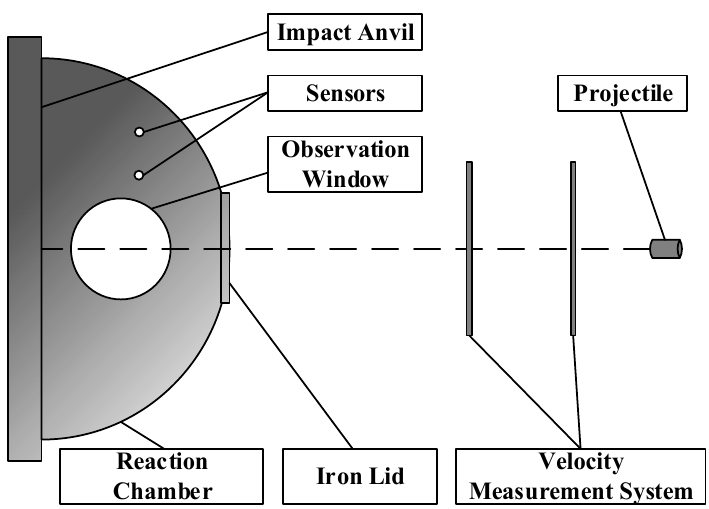
Figure 1. Schematic illustration of the quasi-sealed chamber device. The Zr/PTFE and Ti/PTFE RMs were packed into steel shells to ensure that the materials would not be broken when launching or hitting the iron lid. The size of Zr/PTFE and Ti/PTFE RMs was Φ 10 mm × 9 mm, the mass of cylindrical steel shells was 4.6 ± 0.1 g, and the thickness of the steel shells was 1 mm. A ballistic gun was used to launch the projectiles, and the velocity of the projectiles was adjusted by changing the charge quantity. The velocity of the projectiles was measured through the speed measurement system in front of the ballistic gun. The projectiles passed through the iron lid and hit the impact anvil, causing a strong initial impact inside the RMs, triggering a violent chemical reaction and releasing